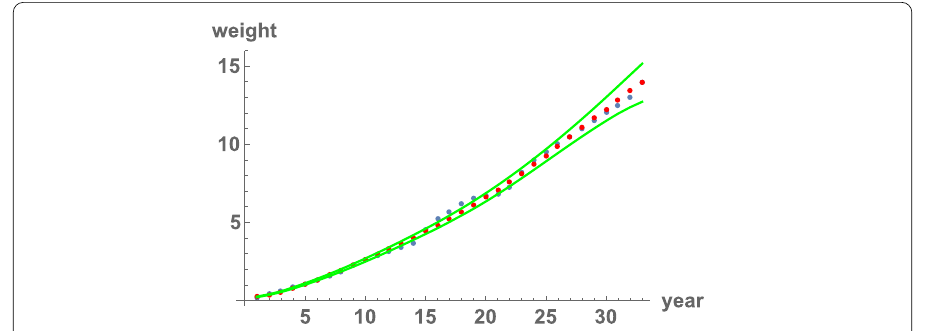
Figure 2 Fit of the fish weight data. The blue points represent the real weights, the red points represent the estimated weights (the mean) and the green lines cover a 95% confidence interval constructed with